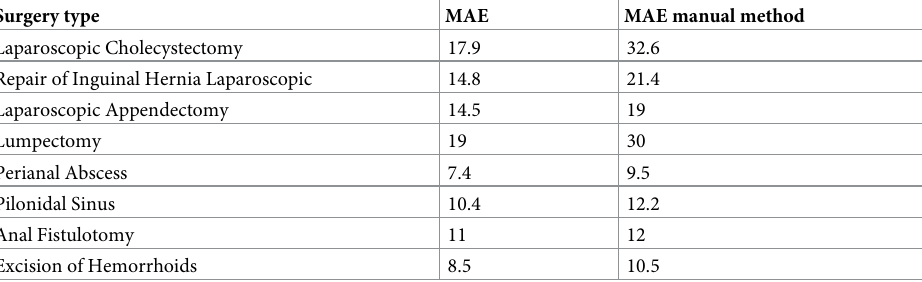
Table 7. GBT model performance by surgery type in terms of MAE (in minutes).